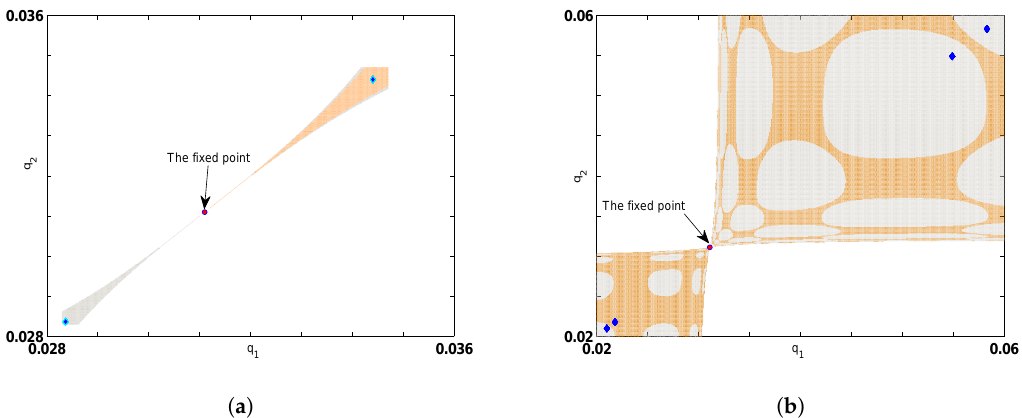
Figure 2. ( a ) Basin of Attraction of period 2-cycle at k = 21.348; ( b ) Basin of Attraction of period 4-cycle at k =